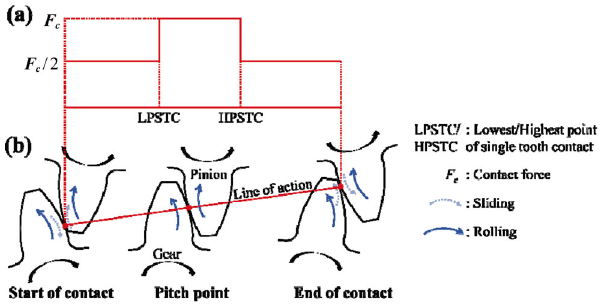
Fig. 3 Contact behavior of the involute spur gear: (a) distribution of the contact force along the line of action and (b) the rolling-sliding contact. Reproduced with permission from Ref. [37],  Elsevier B.V. 1998.